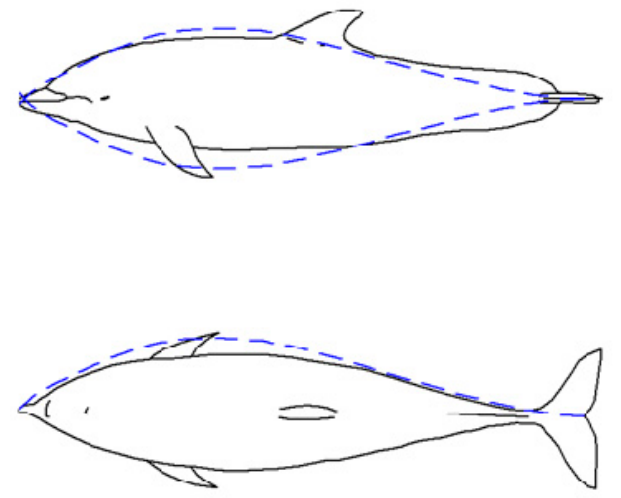
Figure 1. The body of a bottlenose dolphin compared with the closed body of revolution UA-2c